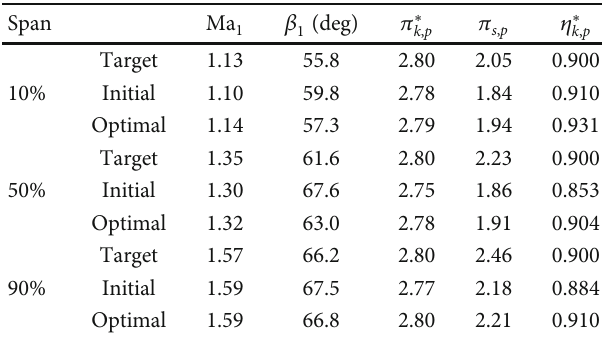
Figure 5: Flow characteristics of inlet section in the supersonic cascade.